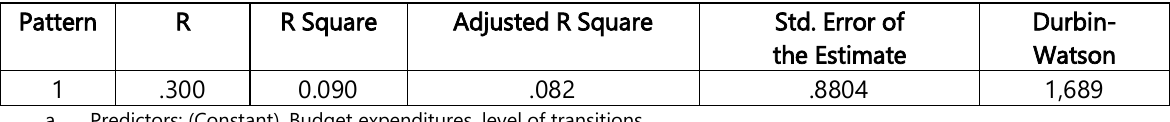
Durbin- the Estimate Watson